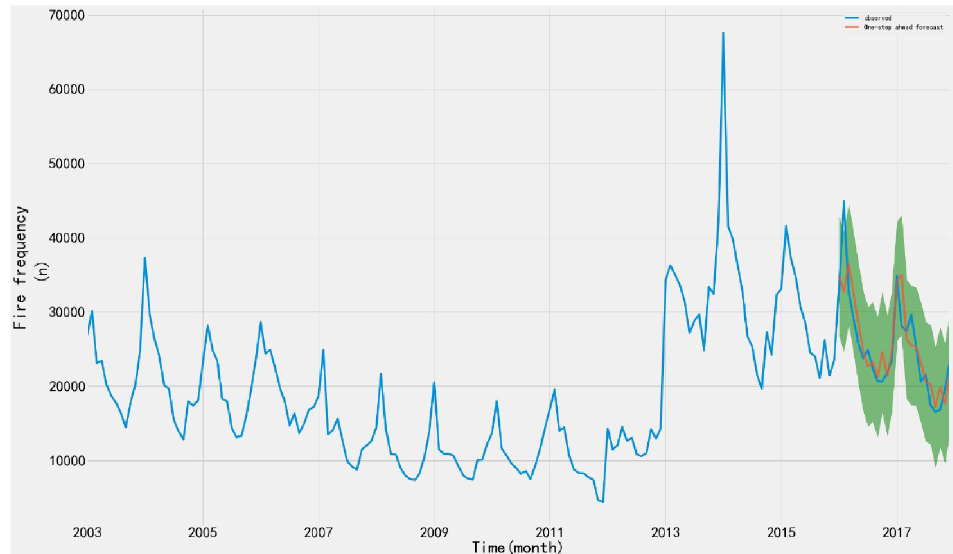
Fig 5. Time series of fire frequency fitting. The model is used to predict the fire data from January 2018 to December 2019, and the prediction results are shown in Fig 8. Compared with the results of the total number of fires in 2018 and 2019 published by the website of the Emergency Management Department, we found that the predicted data are larger than the actual value, and the predicted results show an upward trend, while the actual fire occurrence shows a downward trend year by year (Table 2).